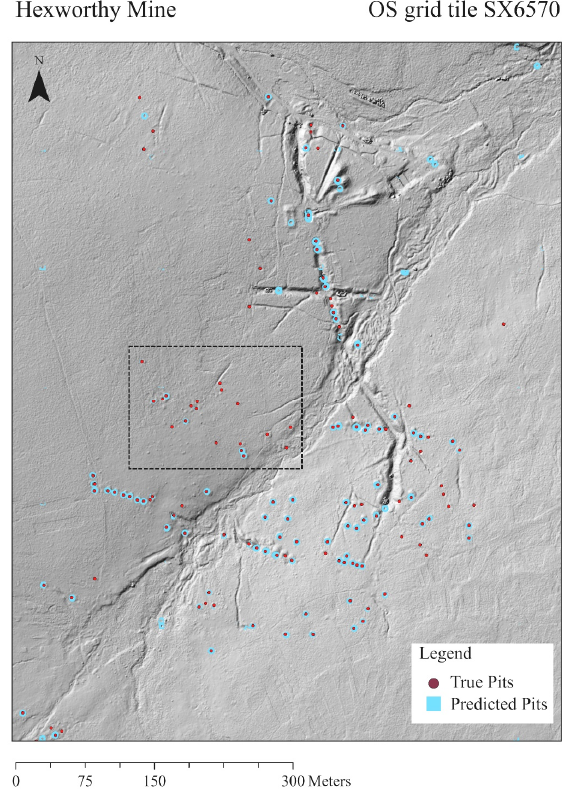
Figure 9. Results in the Dartmoor test area with the true pit locations shown in red and the predicted pit locations in cyan. Base DSM © Environment Agency 2009